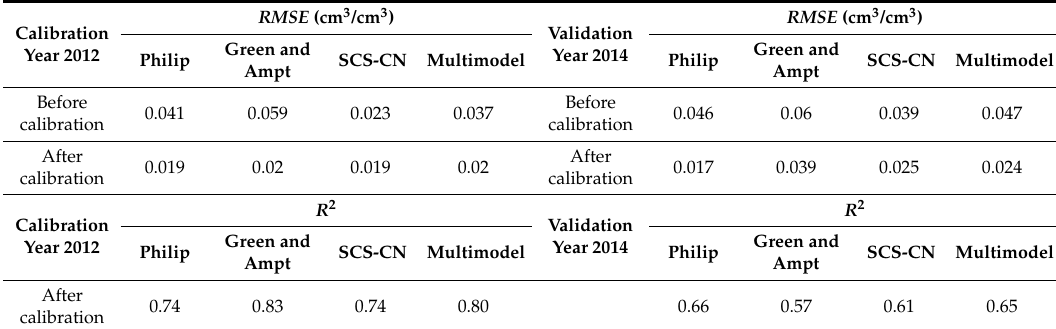
Table 6. Comparison between the performances of the simulation of soil moisture based on different implemented infiltration models before and after calibration for 2012 and 2014 cropping